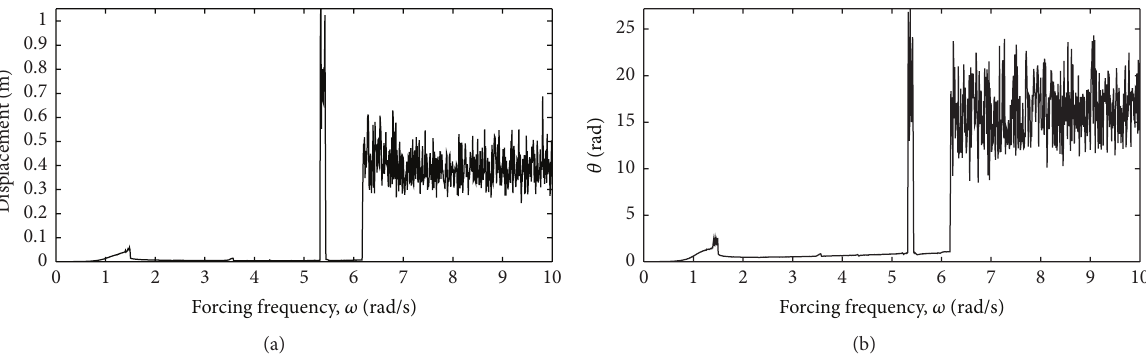
Figure 6: Frequency response curves for Ω min = 15850 rpm: tip response of beam (a); gyro response (b) for 𝑘 = 𝐼 𝑜 𝜔 2 𝑛 /2 = 6.4 Nm / rad with the base excitation of 𝑧 = 0.05 cos (𝜔𝑡) .